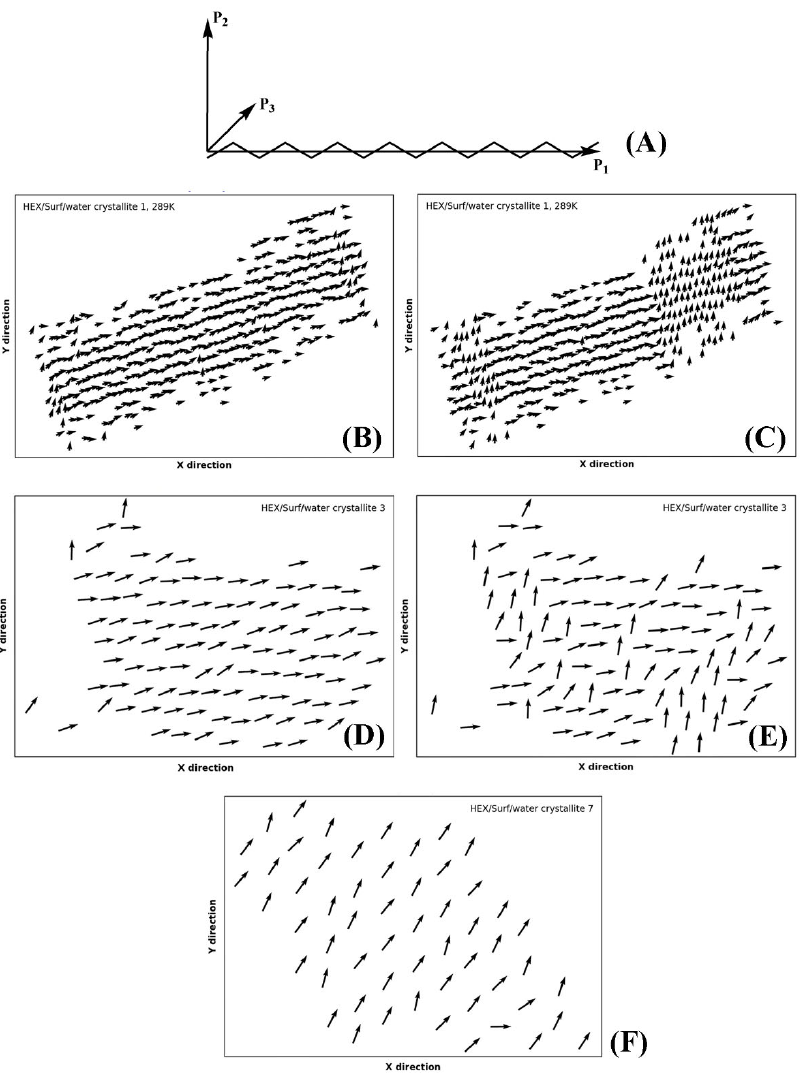
Figure 9. ( A ) Illustration of the three principal axes describing the orientation of the molecule in space; P 1 is aligned with the long molecular axis, P 2 is orthogonal to P 1 and gives insight into the rotation of the molecule about P 1 in space, and P 3 is orthogonal to both P 1 and P 2 ; orientation of the axis P 2 of each molecule in crystallite 1 of HEX/Surf/water simulated at 289 K, in ( B ) crystalline ‐ like state, and ( C ) both ordered states present in the crystallite at once; crystallite 3 of HEX/Surf/water at 278 K in ( D ) the crystalline ‐ like state, and in ( E ) both ordered states in equilibrium; ( F ) crystallite 7 of HEX/Surf/water at 278 K.